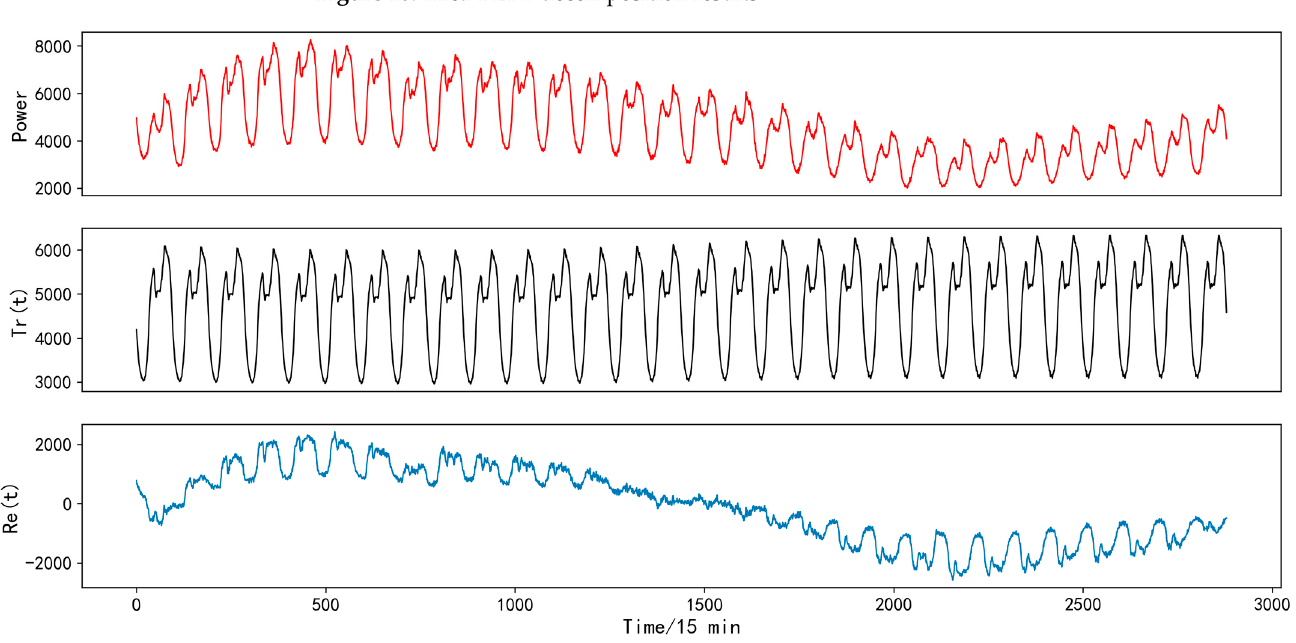
Figure 11. Area 2 EPT decomposition results.